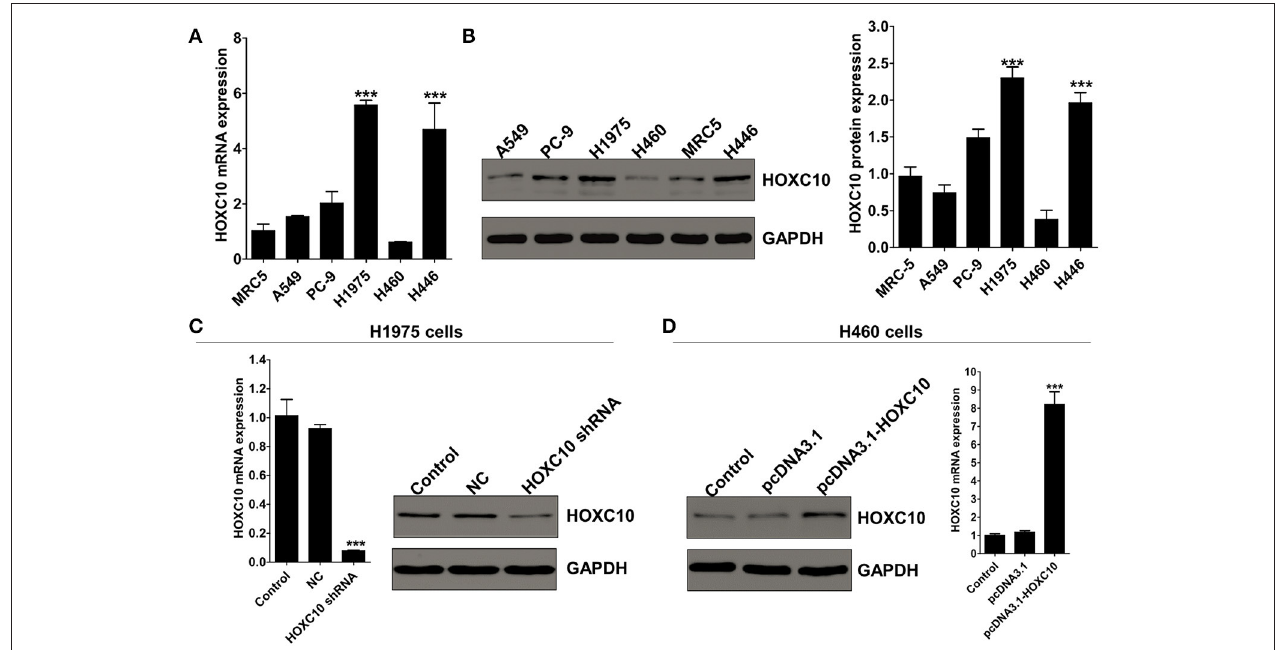
FIGURE 2 | knockdown or ectopic expression of HOXC10 in human lung cancer cell lines. (A) HOXC10 mRNA levels in five lung cancer cell lines and normal lung cells (MRC5). (B) HOXC10 protein expressions in these cell lines evaluated by western blotting. Data are presented as means ± SD , n = 3, *** p < 0.0001 vs. MRC5). (C) H1975 cells were untreated or transfected with either HOXC10 shRNA or scramble shRNA control. HOXC10 expression levels were detected by qRT-PCR and western blotting. (D) H460 cells were untreated or transfected with either pcDNA3.1-HOXC10 or empty vector. HOXC10 expression levels were detected by qRT-PCR and western blotting. Data are presented as means ± SD , n = 3, *** p < 0.0001.